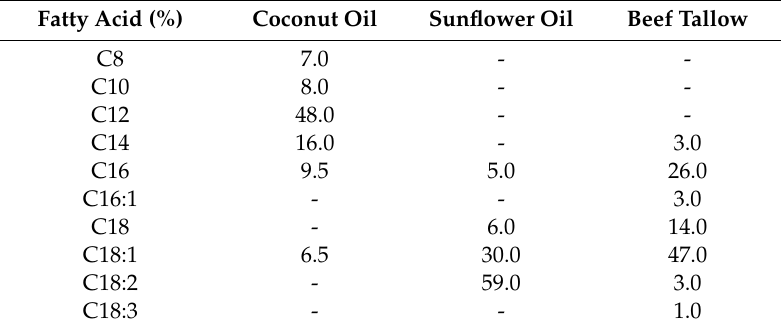
Table 1. Fatty acid composition of dietary lipid preparations